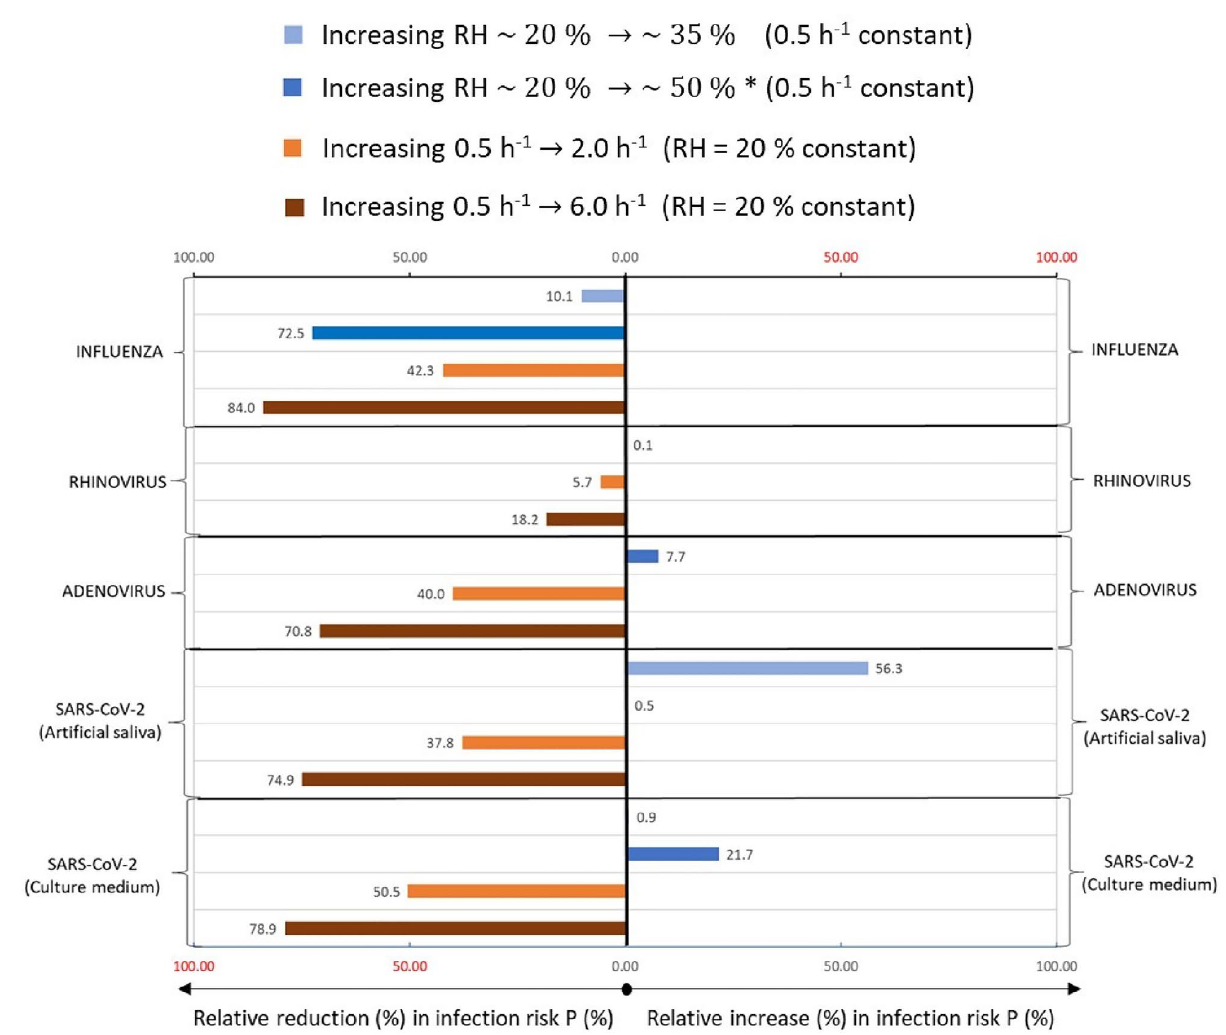
Figure 2. The impact on the relative change in the infection risk of increased humidity from low humidity levels 20% to moderate ≈ 35% and ≈ 50% at constant ventilation rate (0.5 h −1 ) versus the impact of increased ventilation rate from 0.5 to 2 h −1 and 6 h −1 at constant relative humidity (RH ≈ 20%). * ≈ 30% to ≈ 50% for